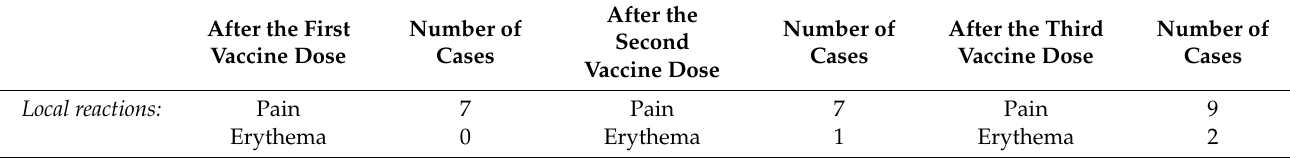
Table 1. Adverse events (AE) in aiRMD patients after the first, second, and third booster doses of the investigated vaccines. The number of mild or moderate local and systemic AE in aiRMDs was 14 (BNT162b2: n = 12, AZD1222: n = 2), 17 (BNT162b2: n = 15, AZD1222: n = 2) and 43 (BNT162b2: n = 43) after the first, second and third vaccines,